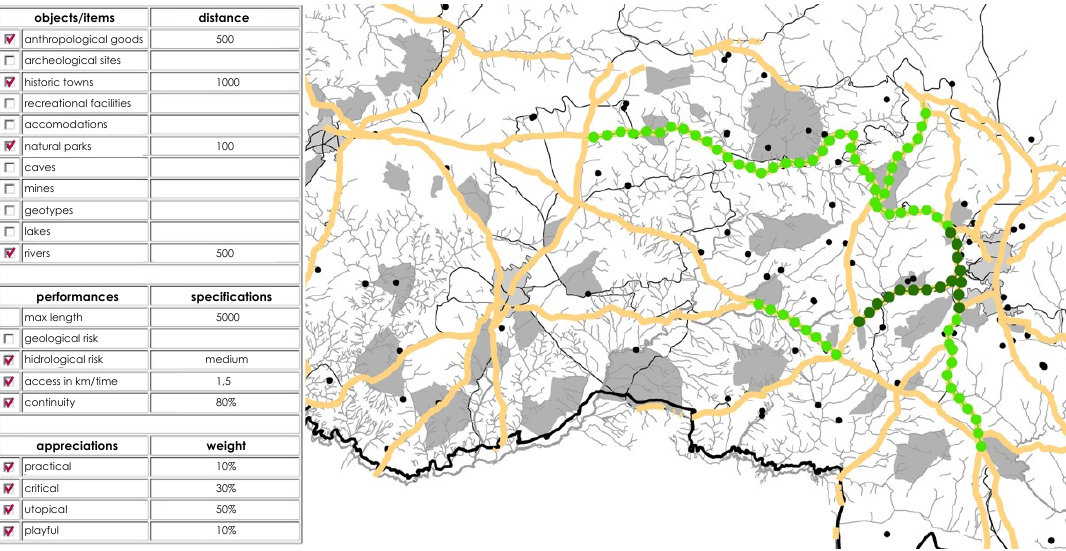
Figure 14. WebGIS interface. Selection of the two path options consistent with the user’s profile entered.